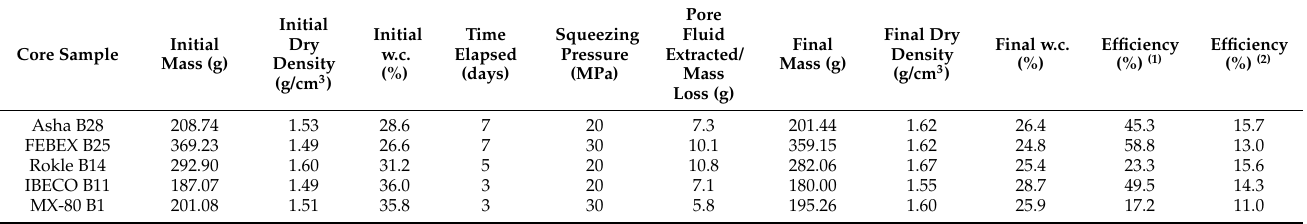
Table 10. Characteristics of the squeezing tests performed from bentonites after ABM5